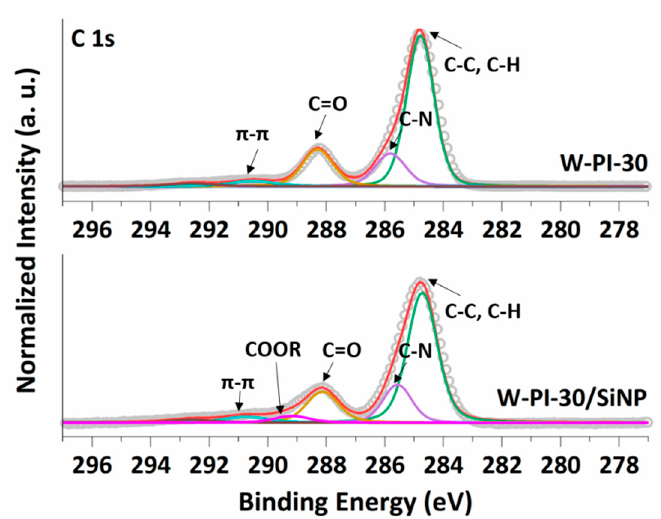
Figure 3. XPS C 1s spectra of W-PI-30 and W-PI-30/SiNP.